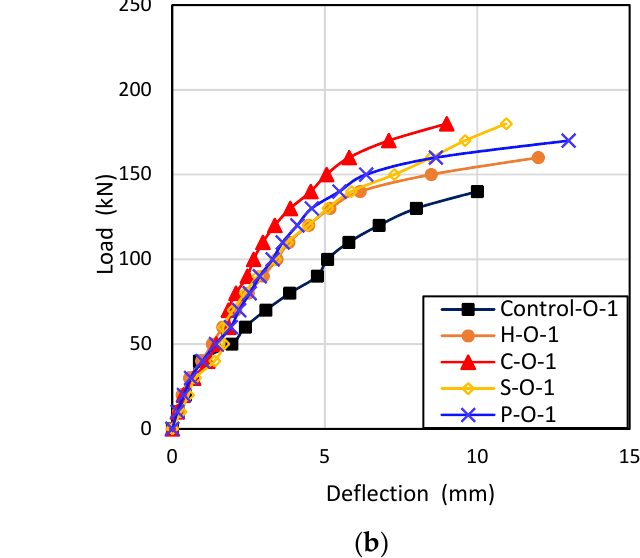
Figure 9. Load–deflection with different types of fiber. ( a ) Control slab with and without opening;